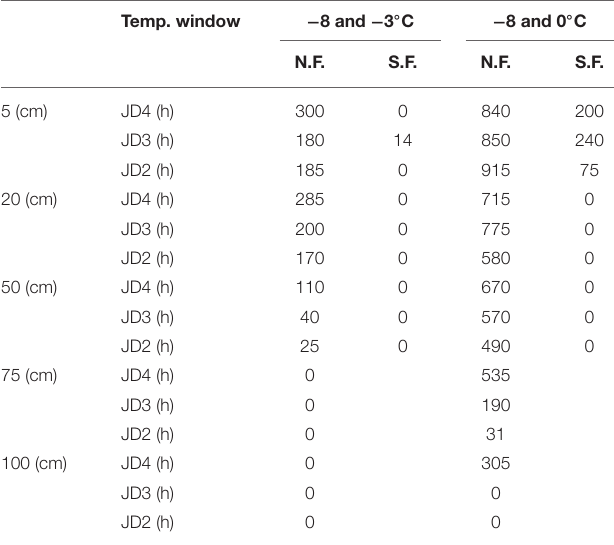
TABLE 3 | The time in hours that the soils at 5, 20, 50, 75, and 100cm depth spend in various temperature windows, measured at the north-facing (N.F.) and south-facing (S.F.) paired instrument sites during the 2012 water year. Temp.